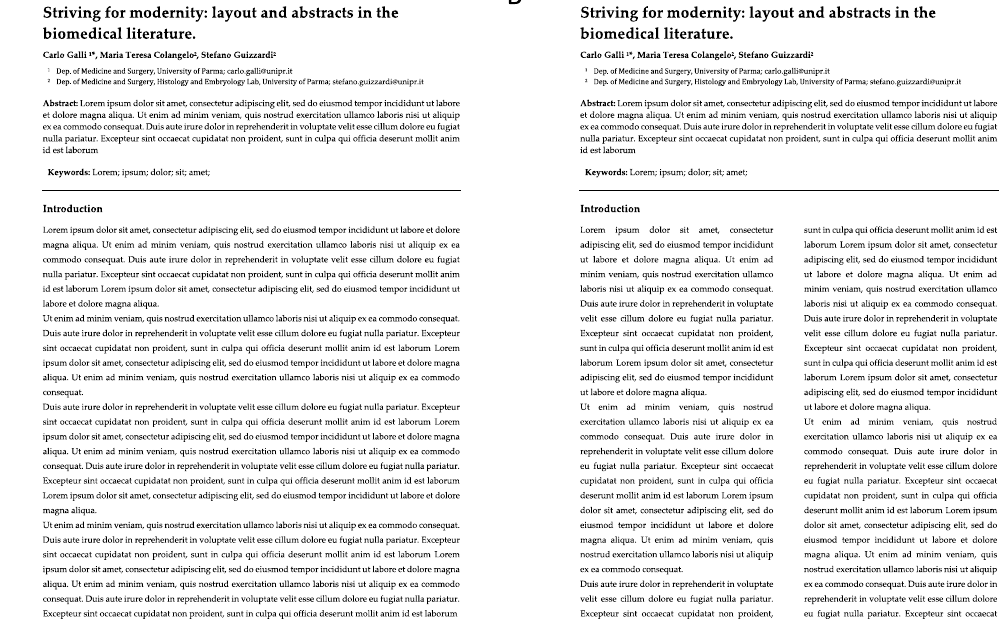
Figure 1. Comparison between two mock-up texts as they would appear in ( A ) a one-column layout or ( B ) a two-column layout. Most academic journals adopted either one of these two formats for their articles.